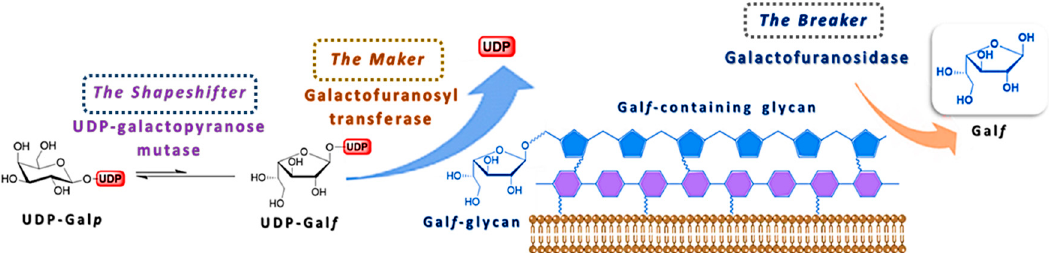
Figure 5. Schematic representation of the Gal f -glycan biosynthesis and the involvement of the three main enzymes, UDP-galactopyranose mutase (UGM), galactofuranosyltransferase (Gal f T) and galactofuranosidase (Gal f -ase).